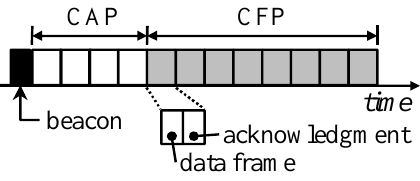
Figure 6. Superframe structure in TUTWSN MAC. CAP and CFP are divided into fixed time slots comprising two subslots, one for data frame and another for acknowledgment. CAP CFP time beacon data